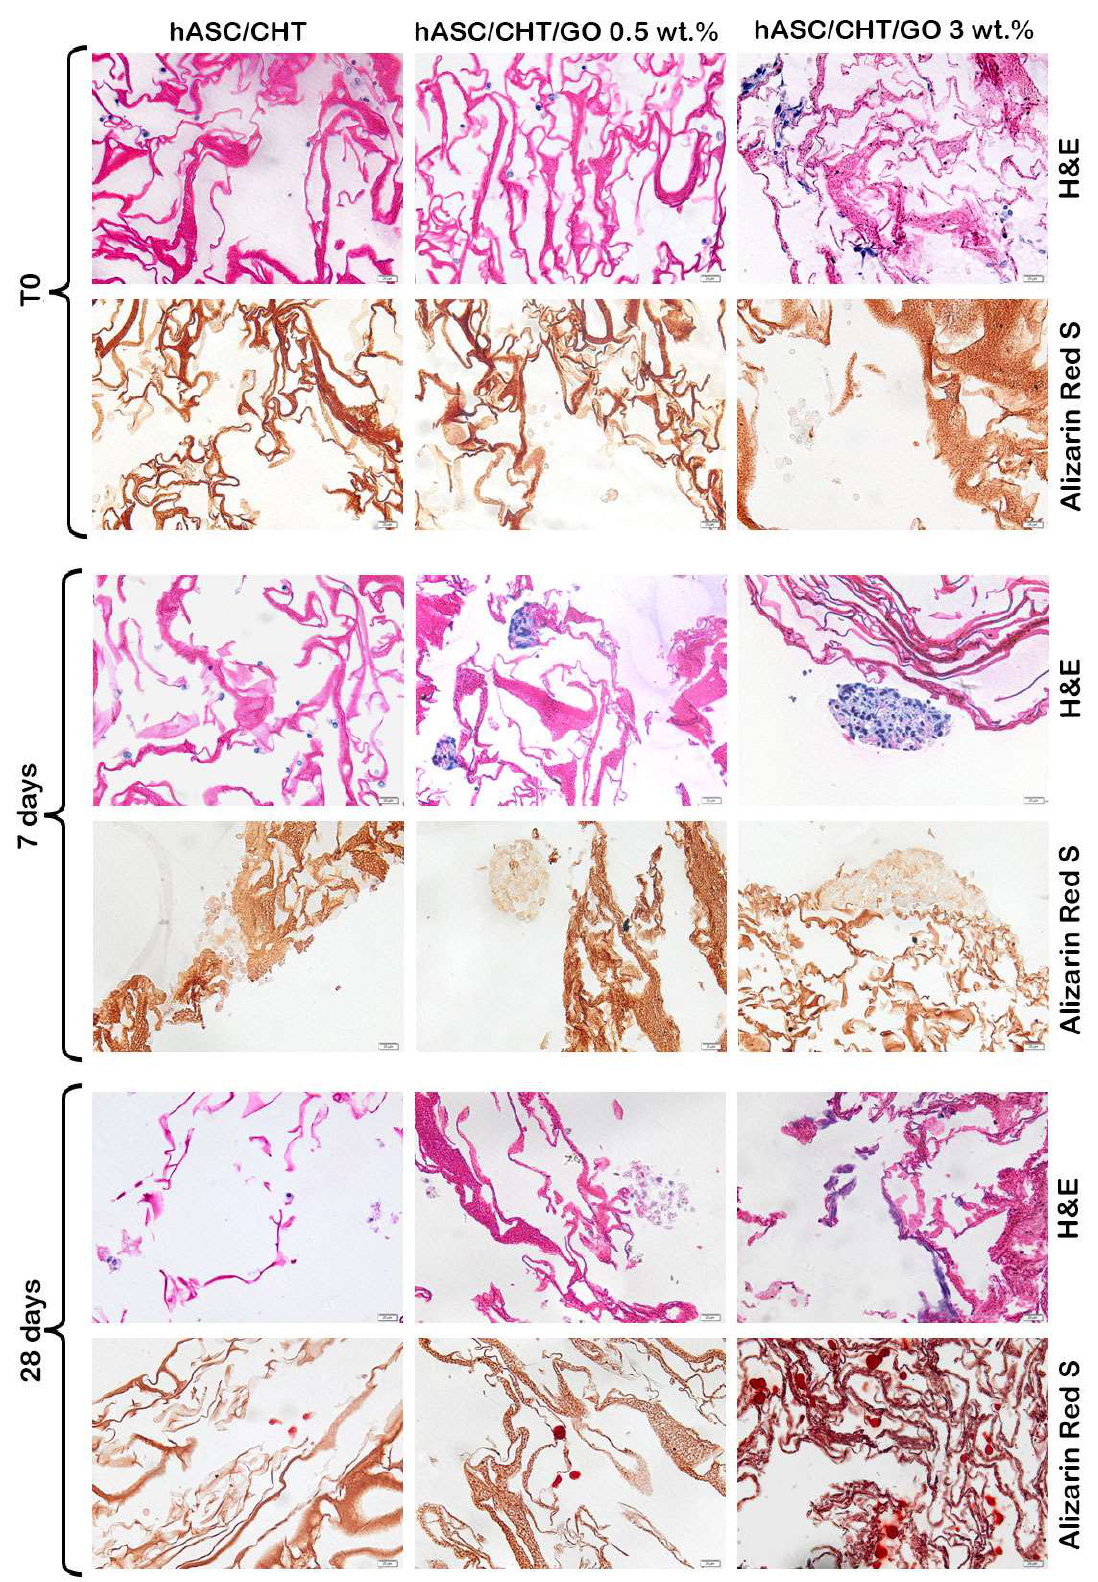
Figure 5. Histological evaluation of osteogenic differentiation. Microtome sections of BC0.5, BC3, and BC stained with hematoxylin-eosin (for morphology) and with Alizarin Red S (to highlight mineral deposits). Scale bar 20 μm.